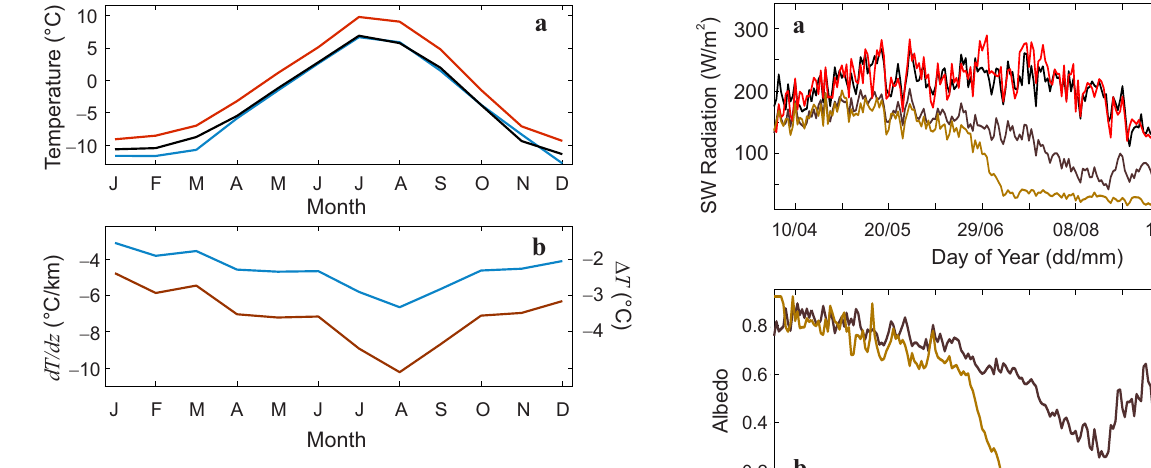
The mean annual GAWS albedo value is 0.75 with a sum- mer value of 0.55 and a minimum of 0.41 in August. The GAWS was established near the median glacier elevation